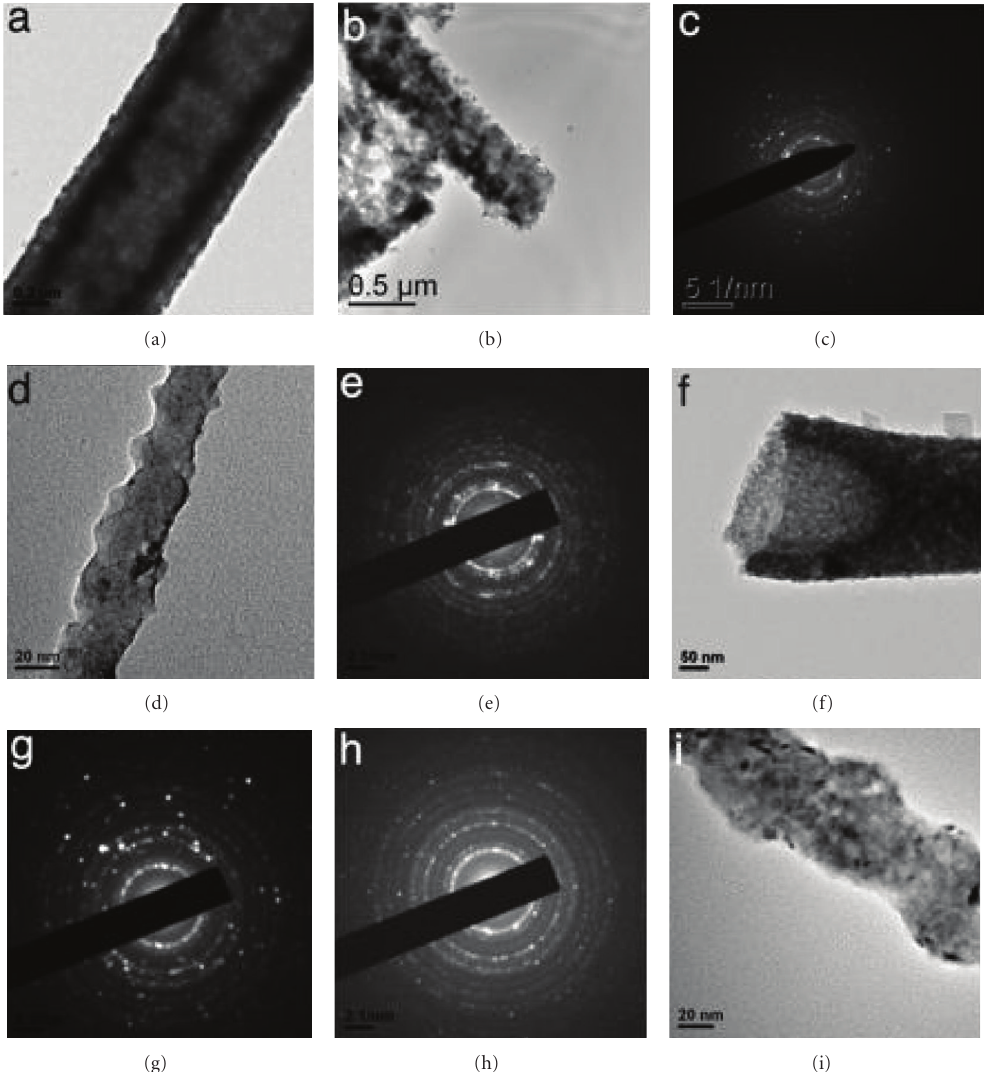
Figure 5: TEM images of (a) hollow BTO calcinated at 500 ◦ C, (b) hollow BTO calcinated at 800 ◦ C, (c) SAED of BTO calcinated at 500 ◦ C, (d) solid BTO calcinated at 800 ◦ C, (e) SAED of BTO calcinated at 800 ◦ C, (f) hollow STO calcinated at 500 ◦ C, (g) SAED of STO calcinated at 500 ◦ C, (h) SAED of STO calcinated at 800 ◦ C, and (i) solid BTO calcinated at 800 ◦